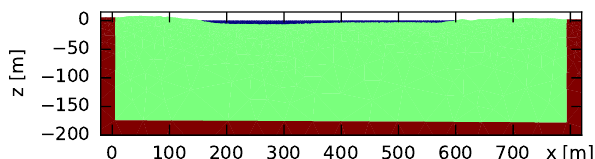
Figure 3. Cropped mesh used for the structurally coupled inver- sion of ERT and seismic data. Three regions are used: (i) the back- ground (in red; much bigger) to prevent influences of the bound- aries, (ii) the parameter domain (green) on which the inversion is done and (iii) the water region (blue), which was